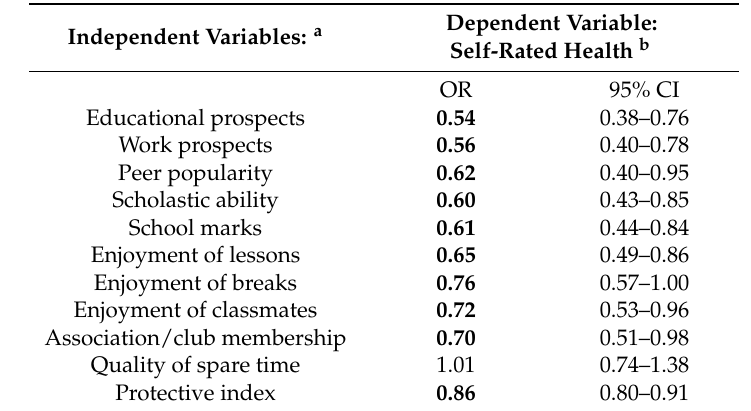
Table 3. Associations between the protective factors (separate model for each factor) at T1 and self-rated health at T2. Results from ordinal regression analyses presented as odds ratios ( n = 908). Statistically significant ( p < 0.05) estimates in bold. Adjusted for gender, internalising symptoms, and functional somatic symptoms at baseline.